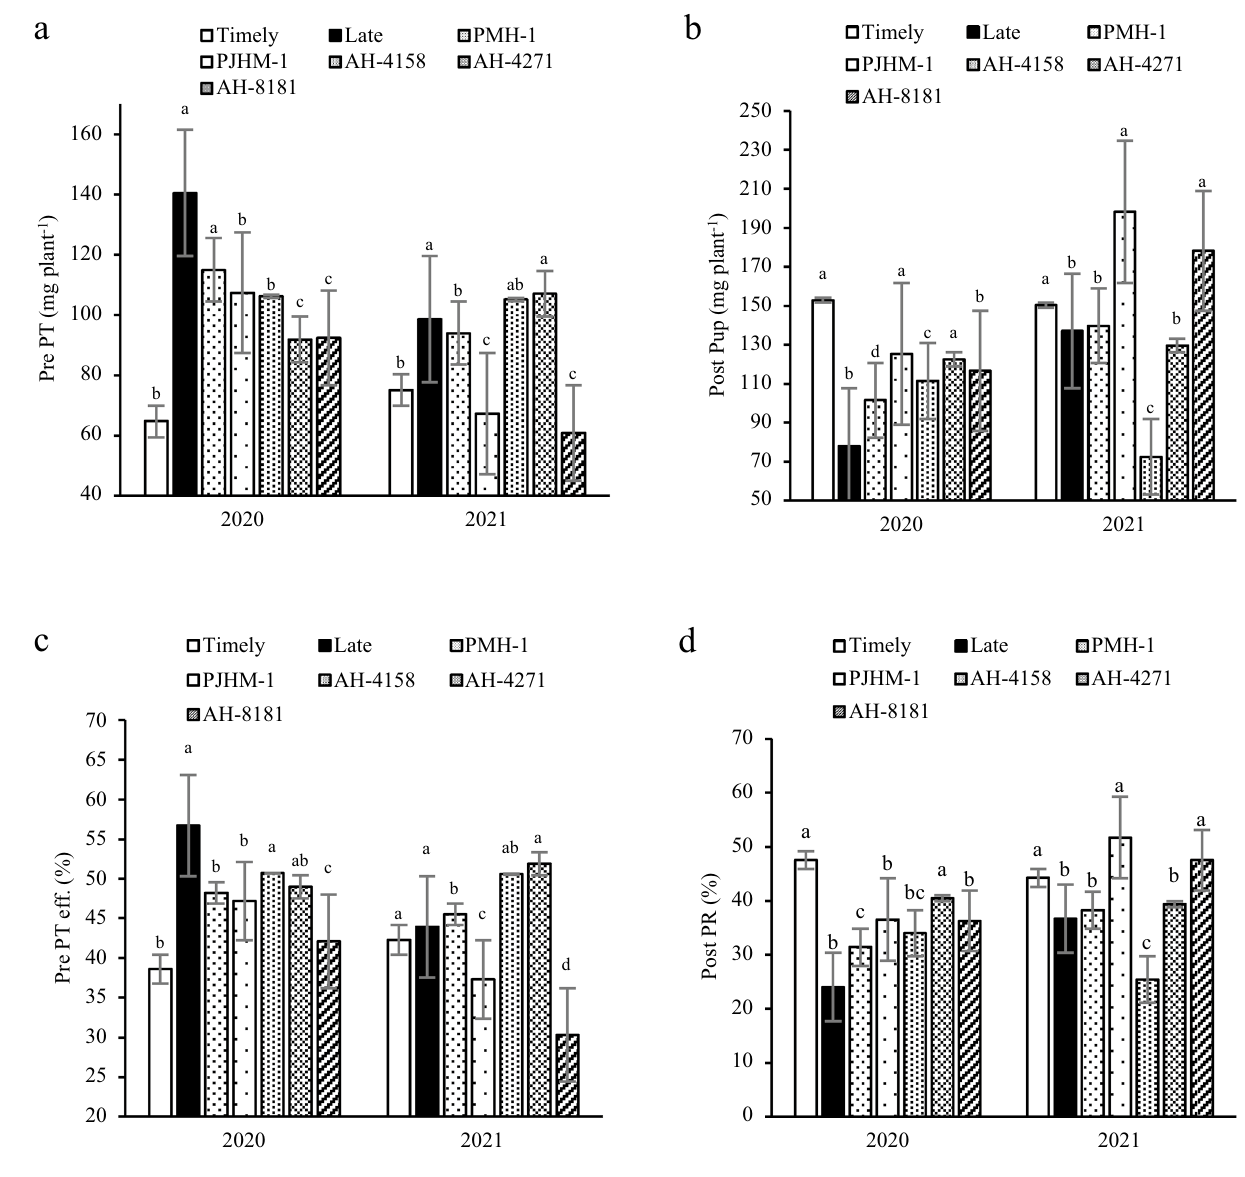
Figure 3. Pre PT- pre-anthesis phosphorus translocation ( a ), Post PuP- post-anthesis phosphorus uptake ( b ), Pre PT-eff.- pre-anthesis Phosphorus translocation efficiency ( c ), Post PR- ratio of post-anthesis P uptake to total P accumulation ( d ). Within years, sowing time, and genotypes, different letters on the individual bars of a figure indicate significant difference ( p ≤